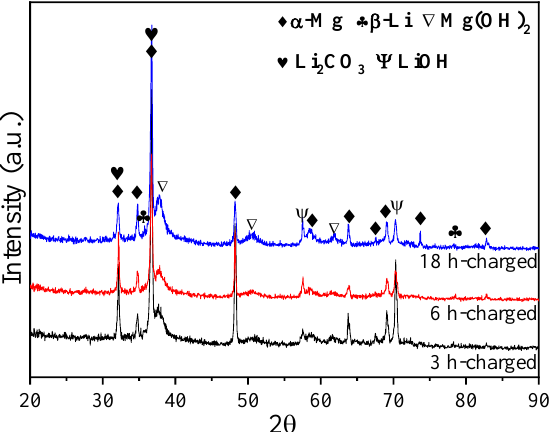
Figure 4. GIXRD patterns of the formed product films for differently charged samples.